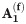
Distributions of five possible A(f) outcomes as produced by initial, permuted A(1).Each pane shows a histogram of the 27 A(1) that eventually lead to the A(f) as noted, where distinctive patterns emerge. Observe a roughly tri-banded distribution for A1(f) and a complementary banding between A3(f) and A4(f). Note how most initial A(1)’s numbered between 1 and 10 lead to A3(f) whereas initial A(1)’s numbered roughly from 20 to 27 lead to A4(f).